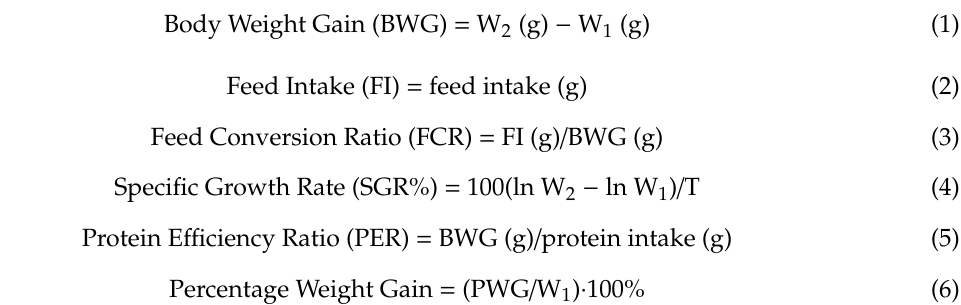
Figure 1. Changes in temperature (°C) and dissolved oxygen (mgO 2 /L) during trial.